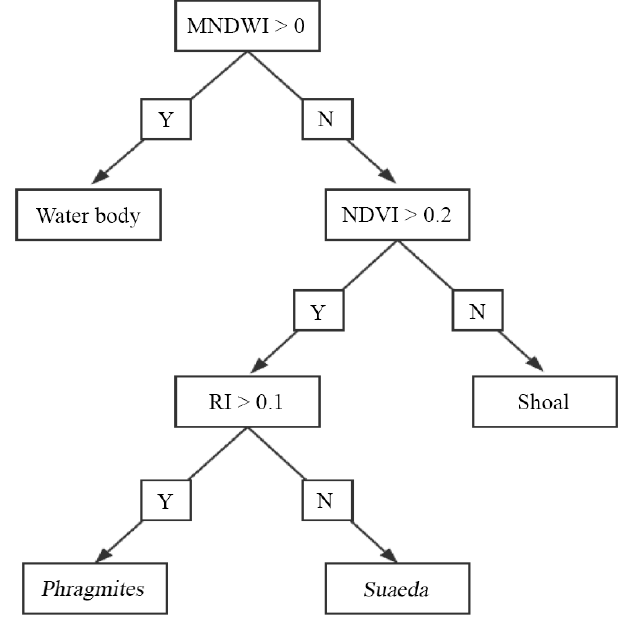
Figure 10. Vegetation classification based on a decision tree.